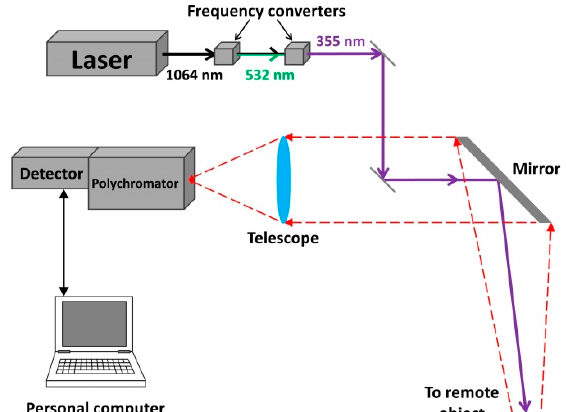
Figure 1. Experimental setup scheme of the LIDAR instrument for laser remote sensing of soils.